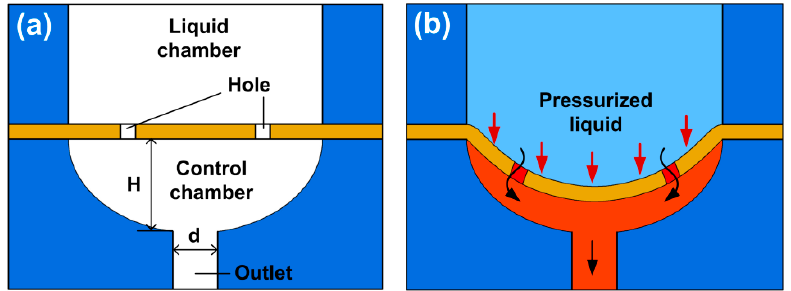
Figure 1. Working principle of the microfluidic passive valve. ( a ) Concept structure of the valve. ( b ) Schematic valve actuation under pressurized liquid.